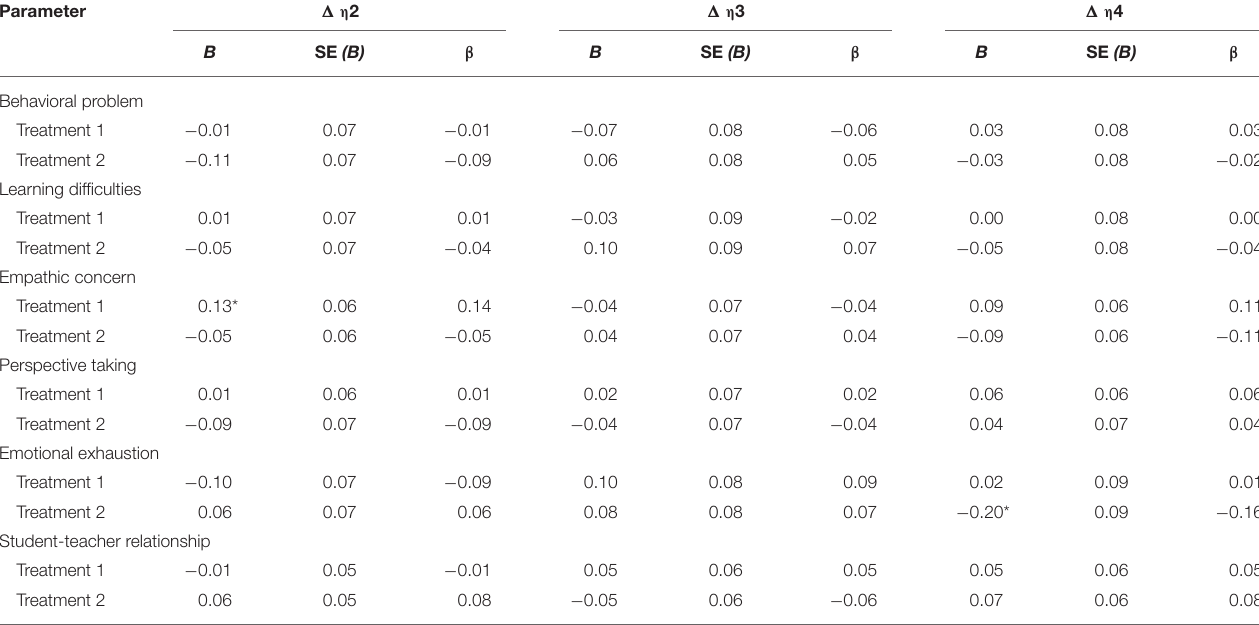
TABLE 5 | Results from LCS modeling (study 2). Parameter